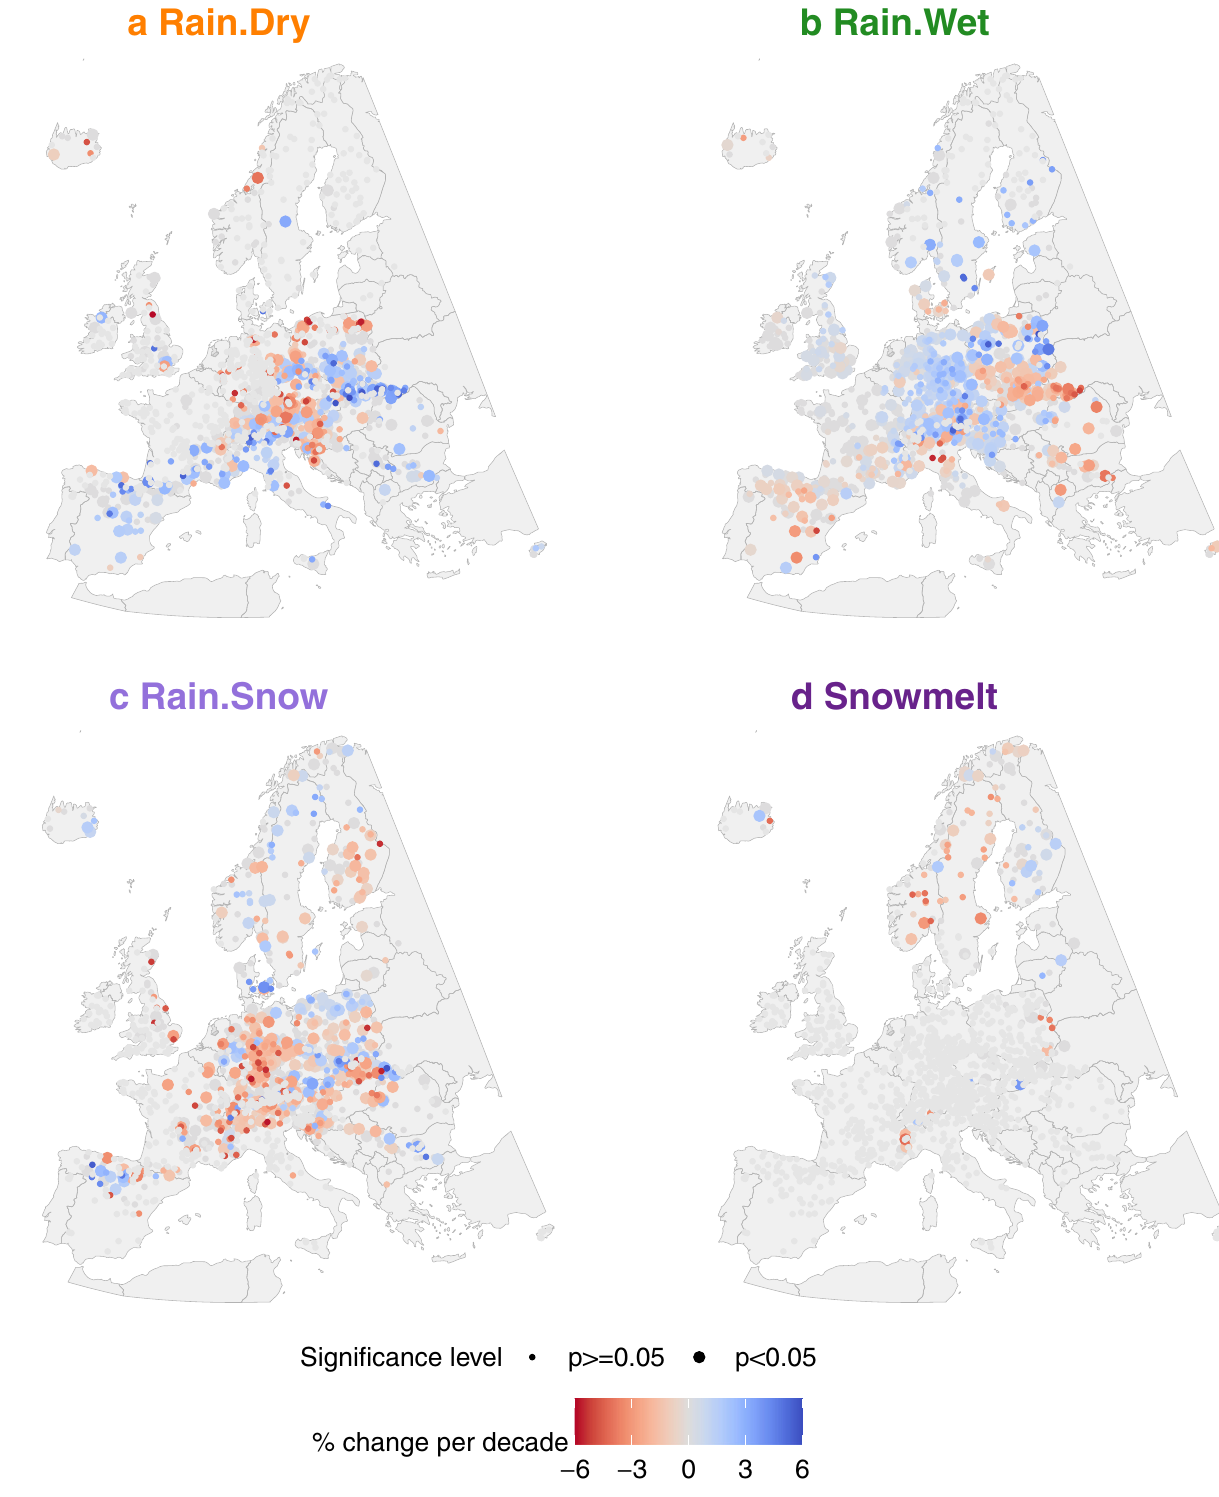
Fig. 1 Changes in the frequency of fl ood generation processes in individual catchments in Europe. a – d Mean change in the frequency [%] per decade over the period 1960-2010 of fl ood generation processes estimated using Sen ’ s slope ( a Rain.Dry, b Rain.Wet, c Rain.Snow and d Snowmelt). Catchments with the signi fi cant changes (Mann-Kendall test, α = 0.05) are indicated as points with larger size. Only catchments with at least fi ve fl ood events generated by a respective process were considered for trend